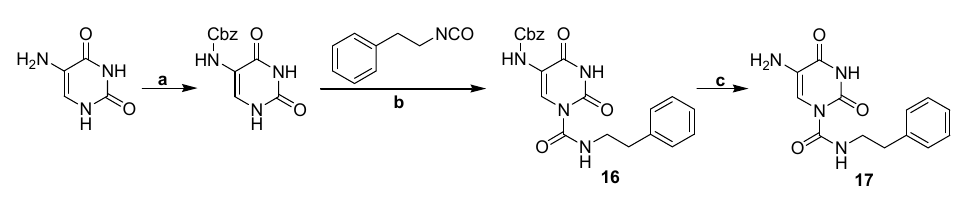
Scheme 1. Preparation of compounds 1 – 15 .